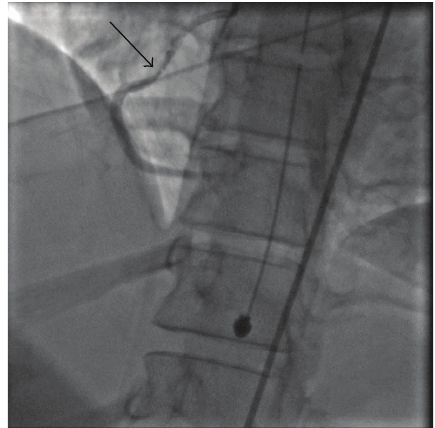
Figure 2: Stenosis seen in RCA became progressively worse after IC NTG and progressed to 99% occlusion. IVUS was performed and demonstrated coronary artery dissection.